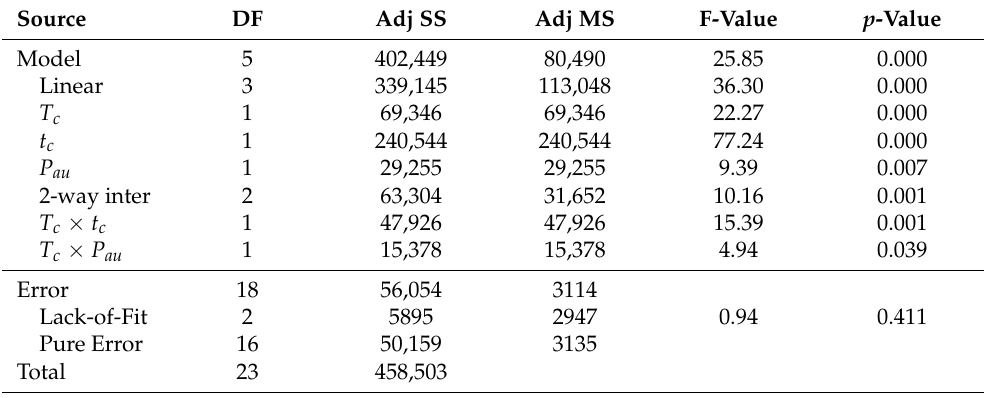
Table 3. ANOVA results for tensile strength. The table shows the significance ( p -value < 0.05) of individual factors T c , t c , and P au , and their interaction ( T c t c ) and ( T c P au ) on the property of tensile strength.